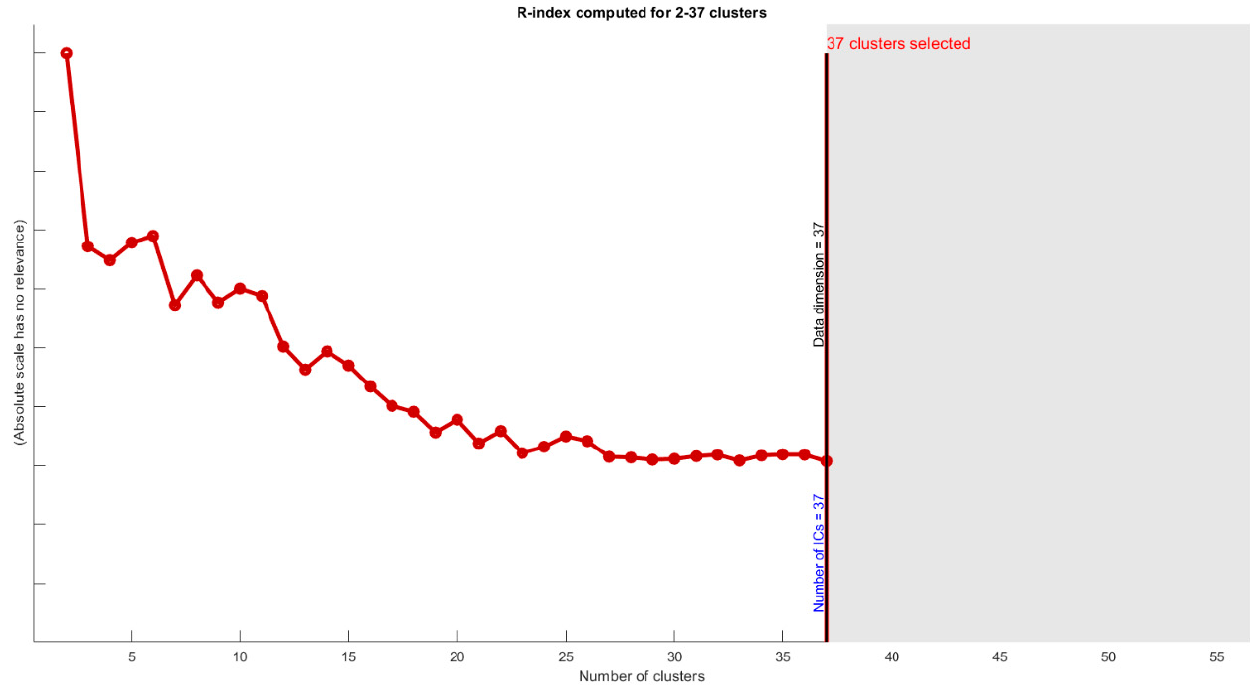
Figure 11. R-index computed for 2–37 cluster showing degree of difference between clusters. Most of the differences will occur for more than 32 clusters.